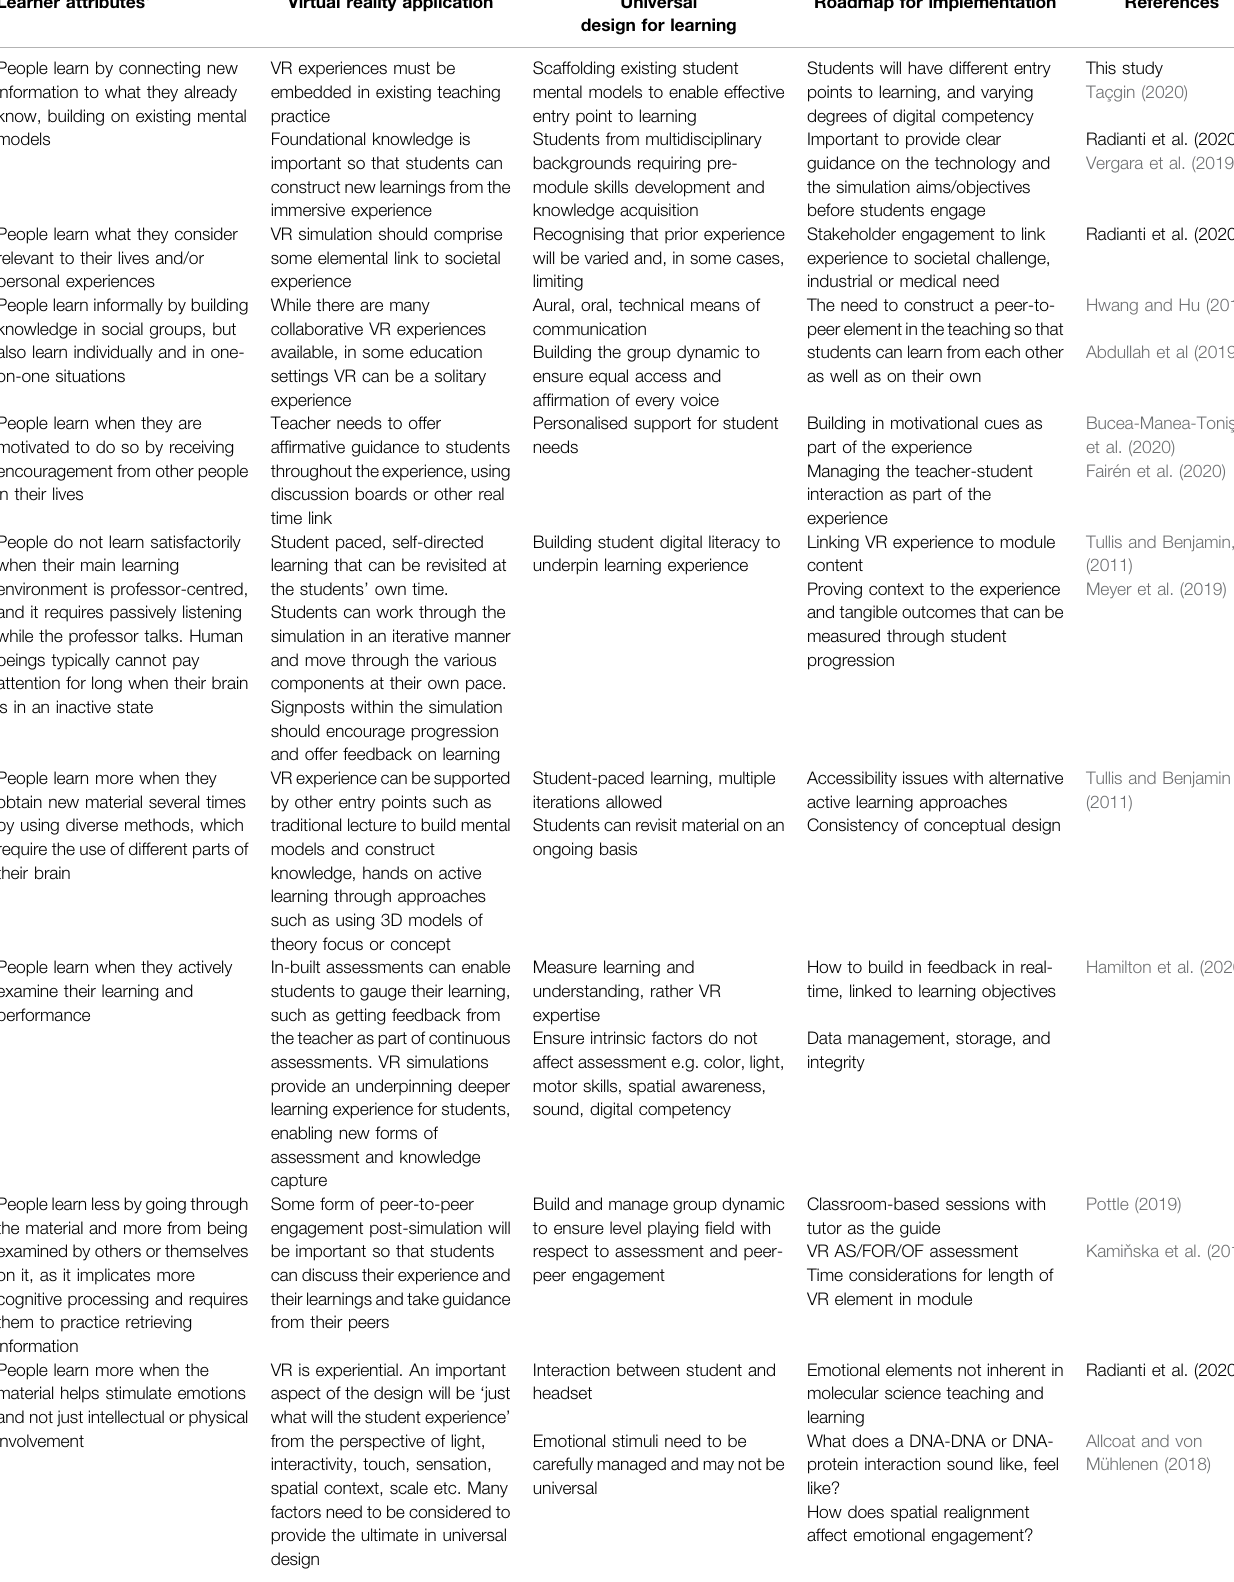
TABLE 1 | Summary of VR applications and the challenges faced in implementing them to address keystone learner